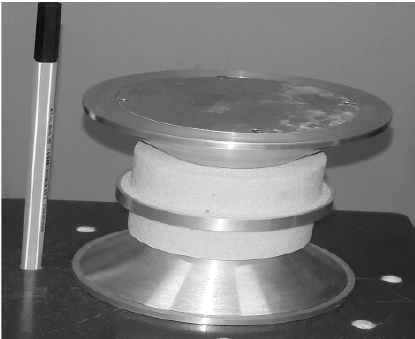
Figure 7: Photograph of Canonical Sleeve Antenna